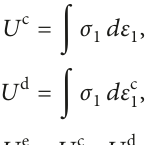
Figure 8: (a) Relationship between the crack closure and peak crack axial strains and σ (c) relationship between ε cc